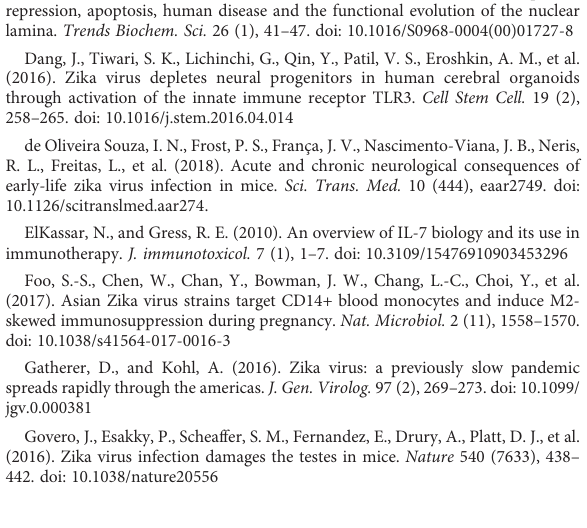
SUPPLEMENTARY FIGURE 1 (A) , Heatmap of differentially expressed immune genes between CAM and GZ01 at 7 dpi. (B) , Functional enrichment of differentially expressed genes between CAM and GZ01 at 7 dpi. SUPPLEMENTARY FIGURE 2 Evaluation of immune checkpoint in tissues from mice infected by each strain. (A) , Calculation of the immune checkpoint scores of mouse brain by GSVA. (B, C) , Differential fold changes of immune stimulation gene from brain at 7 dpi and 14 dpi. (D) , Calculation of immune checkpoint scores of mouse testes by GSVA. *P<0.05; **P< 0.01, ***P< 0.001, ****P<0.0001, ns, not signi fi cant (two-tailed unpaired Student ’ s t-test). SUPPLEMENTARY FIGURE 3 Changes in the immune microenvironment of mice testes. (A) , Viral loads of ZIKV in the mouse shown in line chart. (B) , PCA displaying biological variation among different infection groups. (C) , The proportion of ten main immune cell types. The immune cell ratio was calculated using expression data from the immuCC website. (D) , Comparison of the immune cell ratio of immune cell subtypes in different infection groups. (E) , Comparison of the enrichment scores of immune cell subtypes in different infection groups by